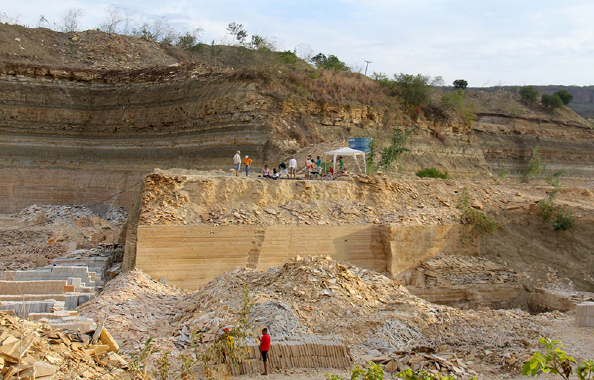
Figure 3. Photograph of the controlled excavations at Antônio Finelon Mine. Nova Olinda municipality, Ceará State, Brazil.